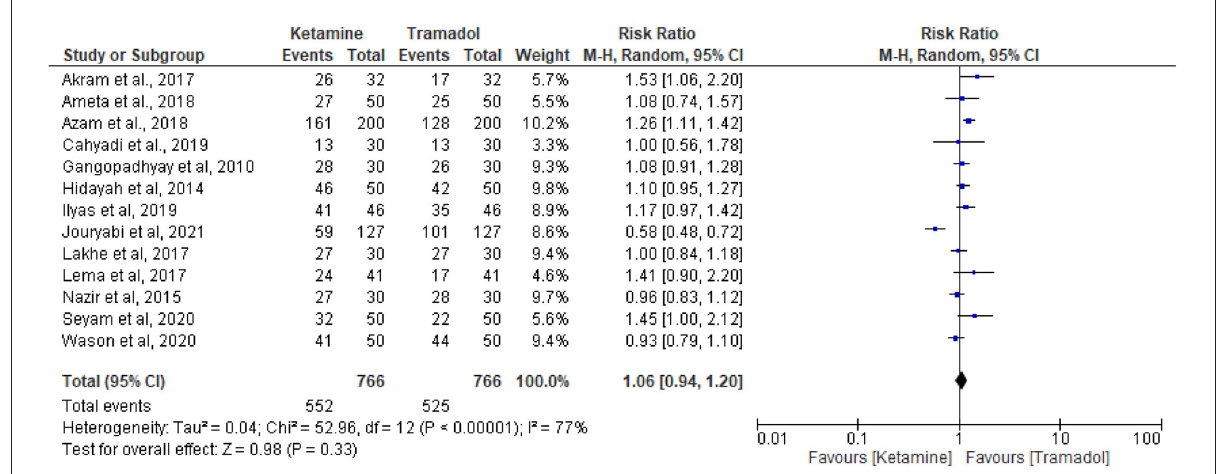
FIGURE3 The effect of ketamine vs. tramadol on the prevention of shivering following spinal anesthesia.